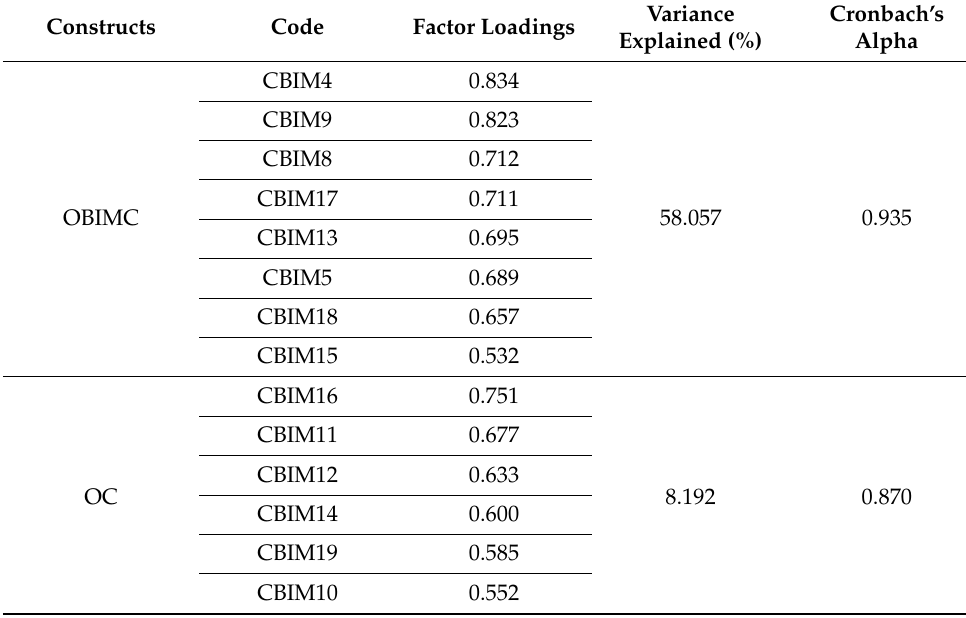
Table 5. Results of FA on capability factors affecting